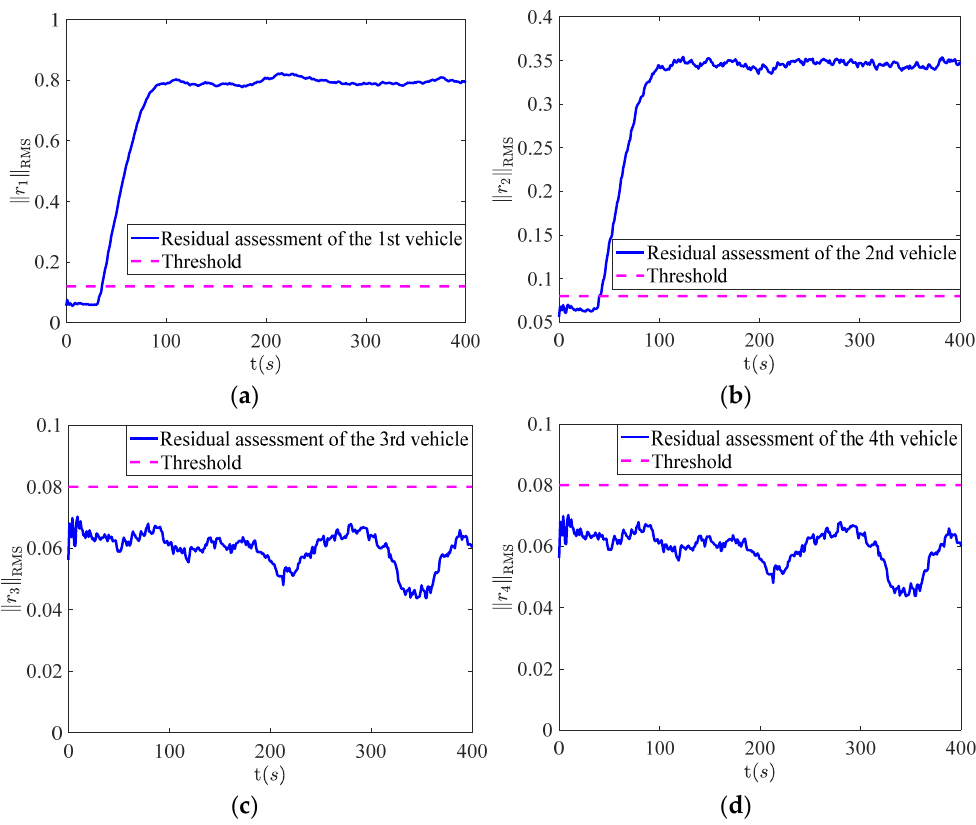
Figure 5. The results of fault detection, where ( a ) represents the 1st vehicle; ( b ) represents the 2nd vehicle; ( c ) represents the 3rd vehicle; ( d ) represents the 4th vehicle.